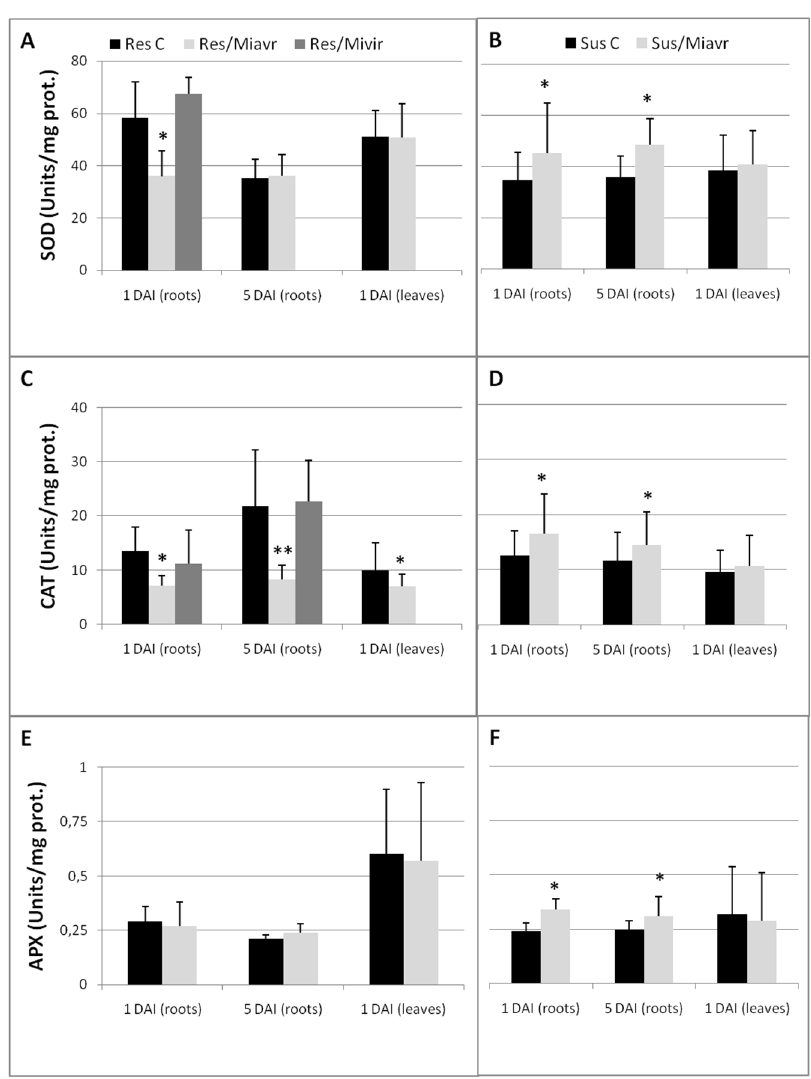
Figure 6. Anti-oxidant enzyme activities of resistant (Res C) and susceptible (Sus C) un-inoculated control plants compared with those of plants inoculated with the avirulent field population Mi-Vfield (Res / -Sus / Miavr) and with the virulent isolate SM2V (Res / Mivir). Superoxide dismutase (SOD— A , B ), catalase (CAT— C , D ), and ascorbate peroxidase (APX— E , F ) activities are expressed as Units mg -1 prot. Protein extraction was carried out using roots 1 and 5 DAI and using leaves 1 DAI. Values are shown as means ( n = 9) ± SD. Means coming from tissues of inoculated plants were separated from those of un-inoculated controls by a t -test; asterisks indicate significant di ff erence (* p < 0.05; ** p < 0.01).